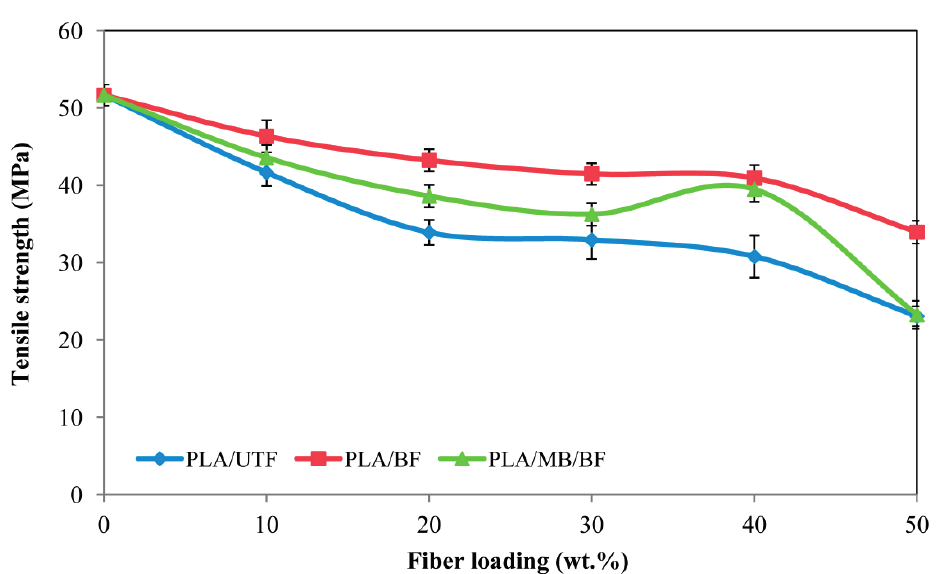
Figure 6. Tensile strength of PLA/UTF, PLA/BF and PLA/MB/BF